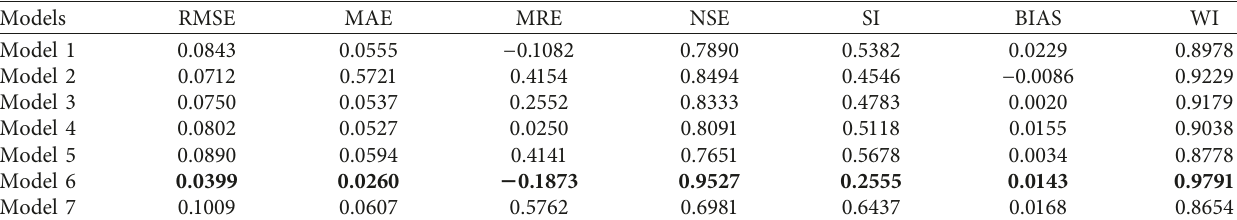
Table 6: The numerical evaluation indicators for the BF-DNN predictive model over the testing modeling